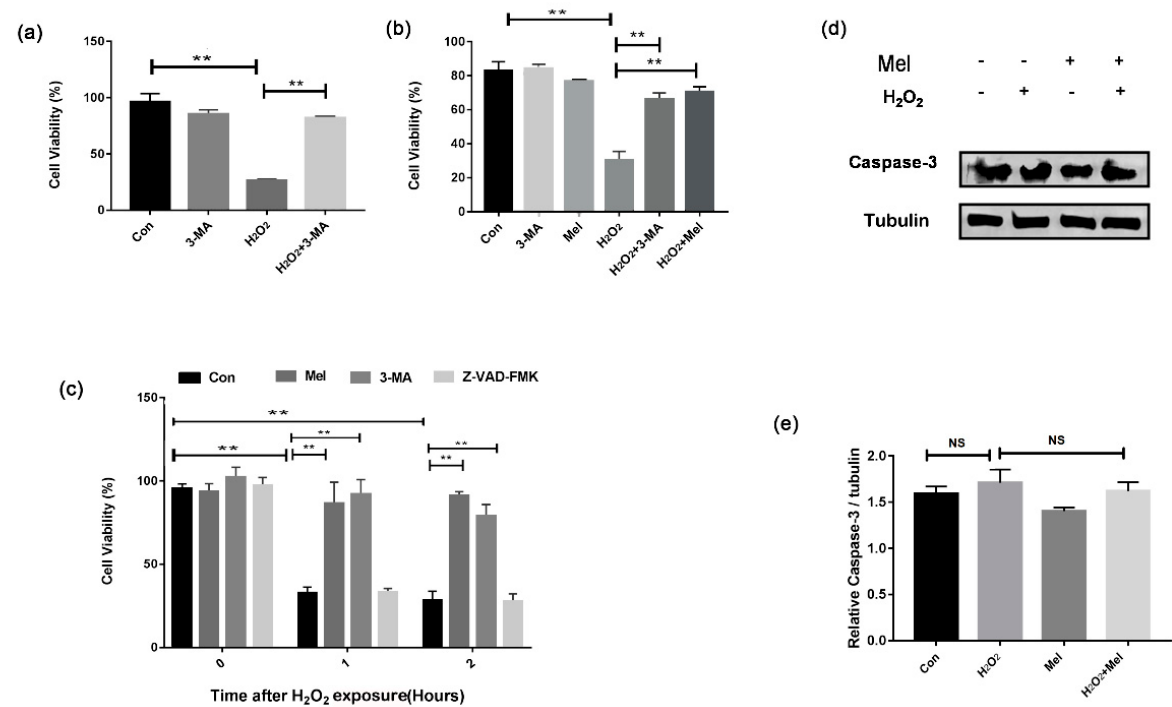
Figure 2. MEL protects GCs from oxidative damage by suppressing autophagy. ( a – c ) Primary GCs were treated with H 2 O 2 (200 µ M) for 1 h, and then cultured with 10 µ M MEL, 50 µ M 3-MA or 50 µ M Z-VAD-FMK, and 0, 1 or 2 h later, cell viability was detected using the CCK-8 assay. ( d,e ) GCs were incubated with 200 µ M H 2 O 2 for 1 h, then treated with or without MEL for 2 h. The expression of caspase-3 in GCs was determined by Western blotting. α -tubulin served as the control for loading. Experiments were repeated in triplicate. Data represent mean ± S.E; n = 3. ** Represents p < 0.01 compared to control group.